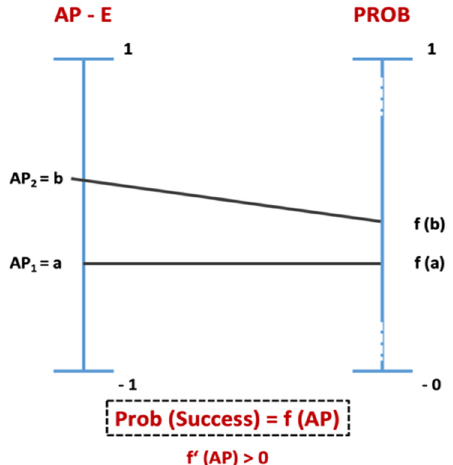
Figure 7. Average Presence and Probability of Success. Source: the authors.